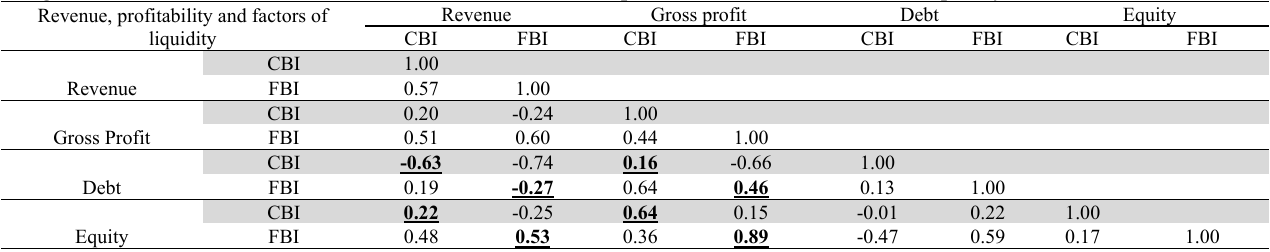
Long-term and short-term cohesiveness between revenue, net profit and factors of financial liquidity Revenue, profitability and factors of